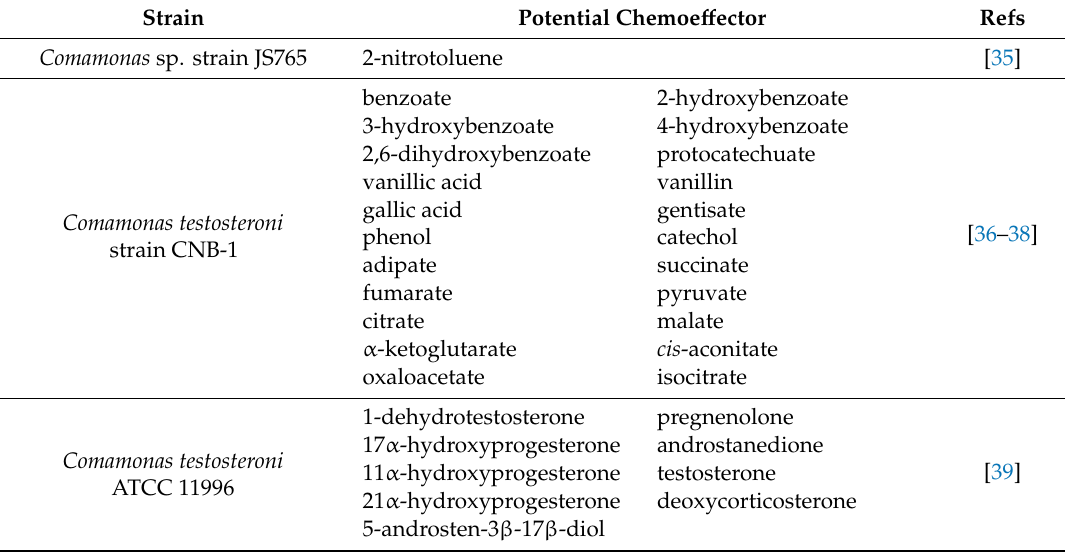
Table 1. Summary of the chemotactic responses of Comamonas species to various organic compounds. Strain Potential Chemoe ff ector Refs Comamonas sp. strain JS765 2-nitrotoluene [35] benzoate 2-hydroxybenzoate [36–38]3-hydroxybenzoate 4-hydroxybenzoate 2,6-dihydroxybenzoate protocatechuate vanillic acid vanillin gallic acid gentisate Comamonas testosteroni phenol catechol strain CNB-1 adipate succinate fumarate pyruvate citrate malate α -ketoglutarate cis -aconitate oxaloacetate isocitrate 1-dehydrotestosterone pregnenolone [39]17 α -hydroxyprogesterone androstanedione Comamonas testosteroni 11 α -hydroxyprogesterone testosterone ATCC 11996 21 α -hydroxyprogesterone deoxycorticosterone 5-androsten-3 β -17 β